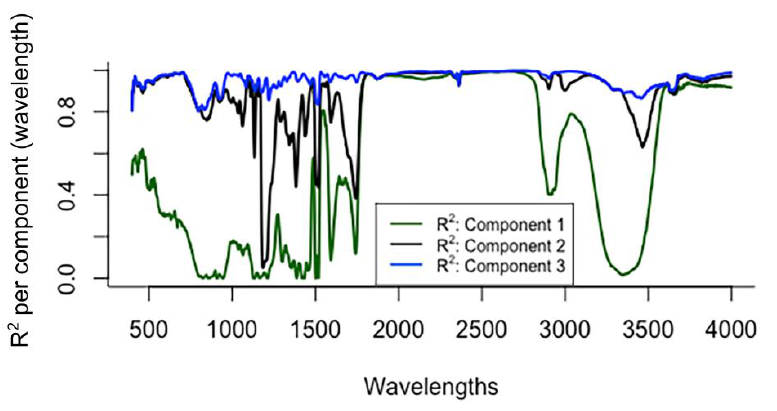
Figure 13. Determination coefficient R 2 for each main component.